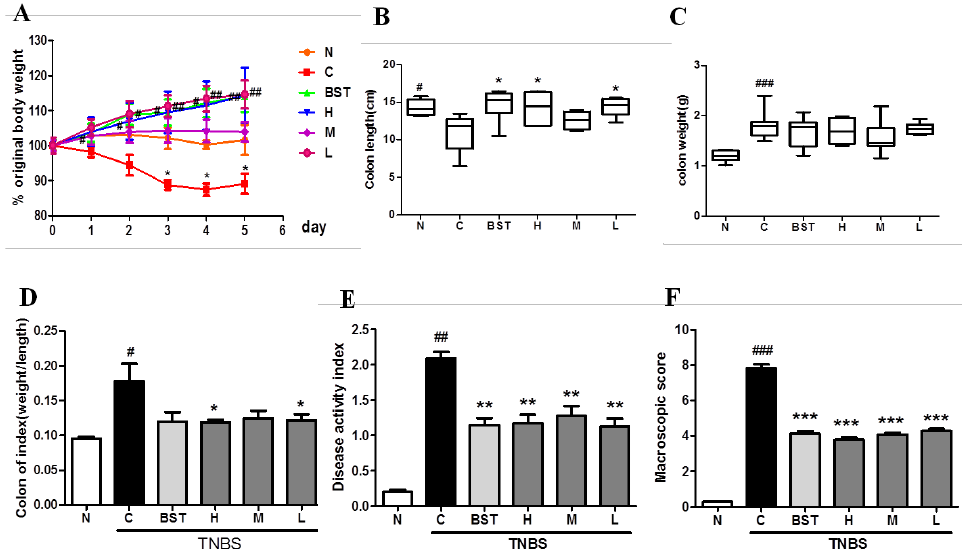
Figure 1. Citrus aurantium L. (CAL) alleviates 2,4,6-trinitrobenzene sulfonic acid (TNBS)-induced colitis in rats. The time-course of changes on day 4 after TNBS-induced inflammatory bowel disease (IBD) in ( A ) body weight; ( B ) colon length; ( C ) colon weight; ( D ) the ratio of weight/length; ( E ) disease activity index (DAI) score; and ( F ) macroscopic injury score. N: normal group; C: control (TNBS only) group; BST: balsalazide 1 g/kg + TNBS group; H (high): CAL 500 mg/kg + TNBS group; M (medium): CAL 250 mg/kg + TNBS group; L (low): CAL 125 mg/kg + TNBS group; n = 8, # p < 0.05, ## p < 0.01, ### p < 0.001 vs. normal group; * p < 0.05, ** p < 0.01, *** p < 0.001 vs . control group.